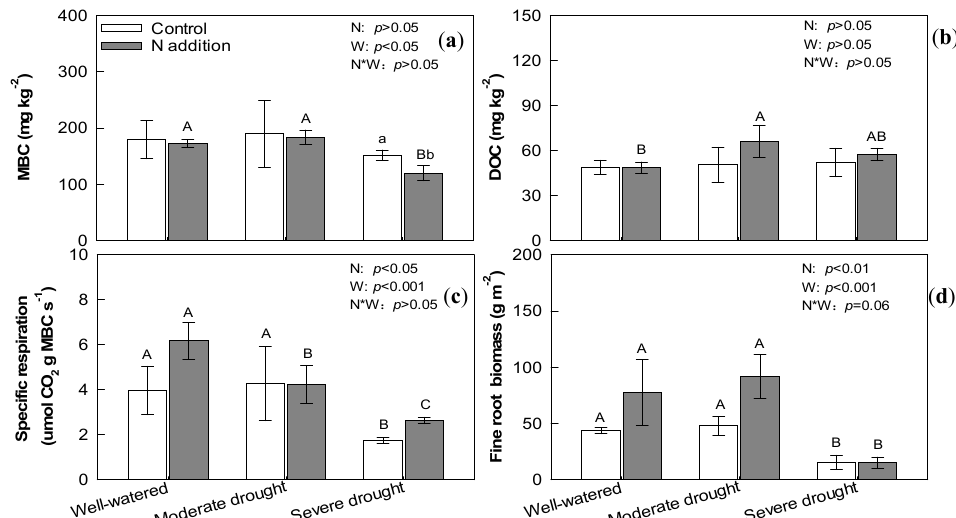
Figure 5. Soil microbial carbon (MBC) content ( a ) and dissolved organic carbon (DOC) content ( b ), specific respiration ( c ), and fine root biomass ( d ) under different treatments. The error bar represented arithmetic means ± standard errors for three replicates. Different superscript indicates significant differences between N addition treatments under the same drought treatment (lowercase letters) and different drought treatments under the same N addition treatment (uppercase letters). * represents interactions.